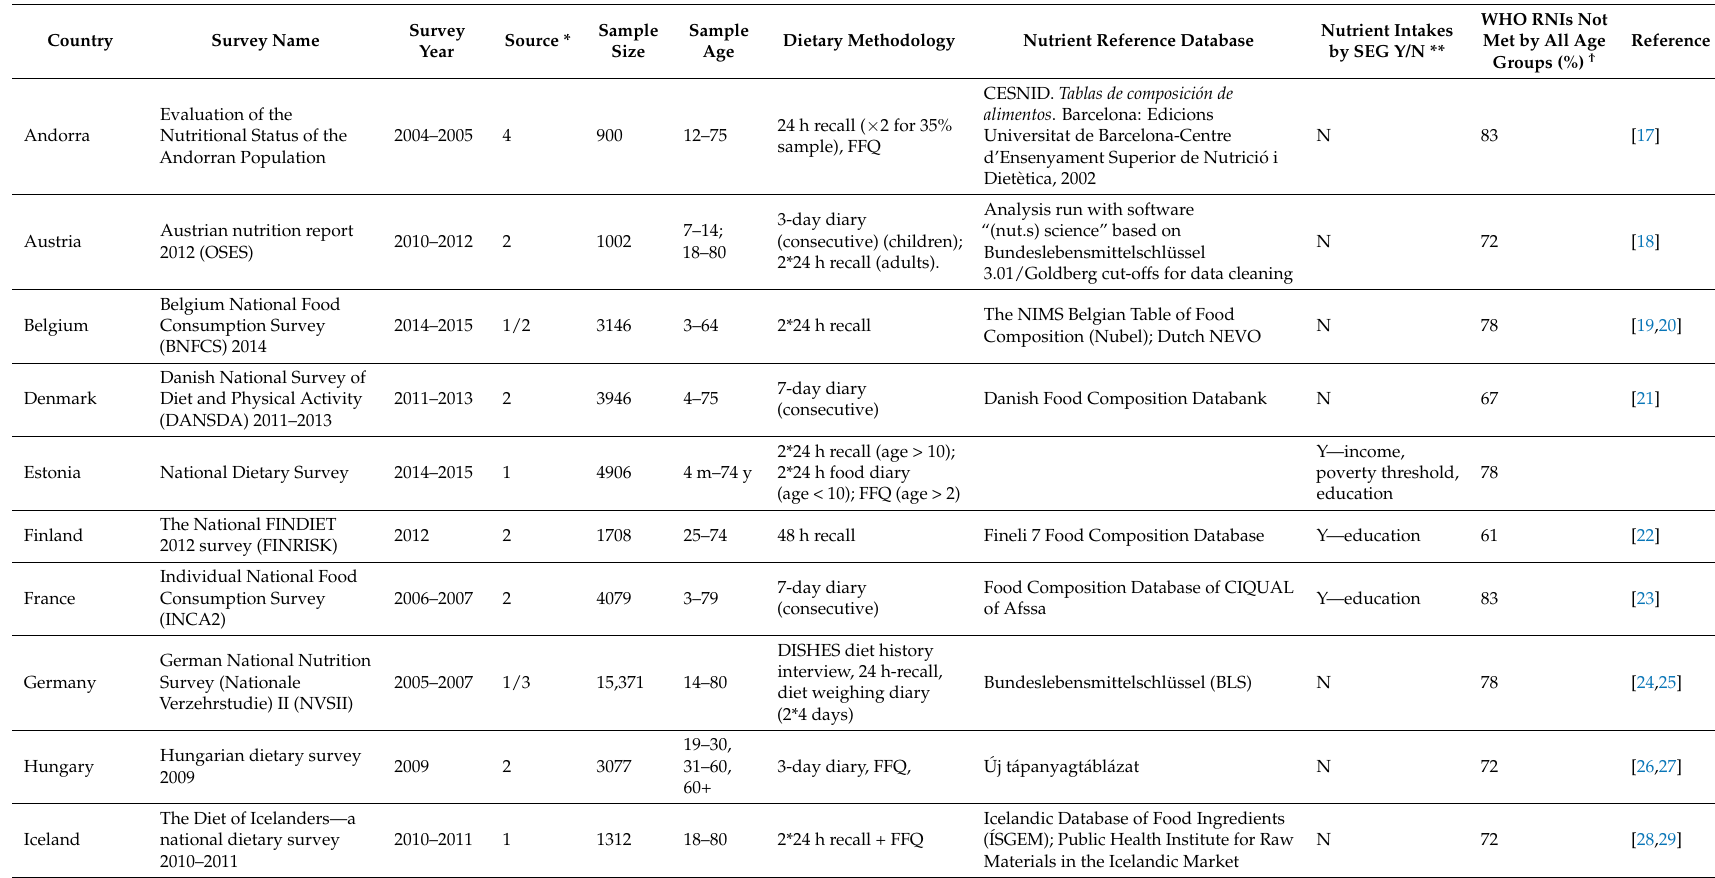
Table 3. National diet surveys across countries in WHO Europe 1990–2016 with nutrient intakes reported.